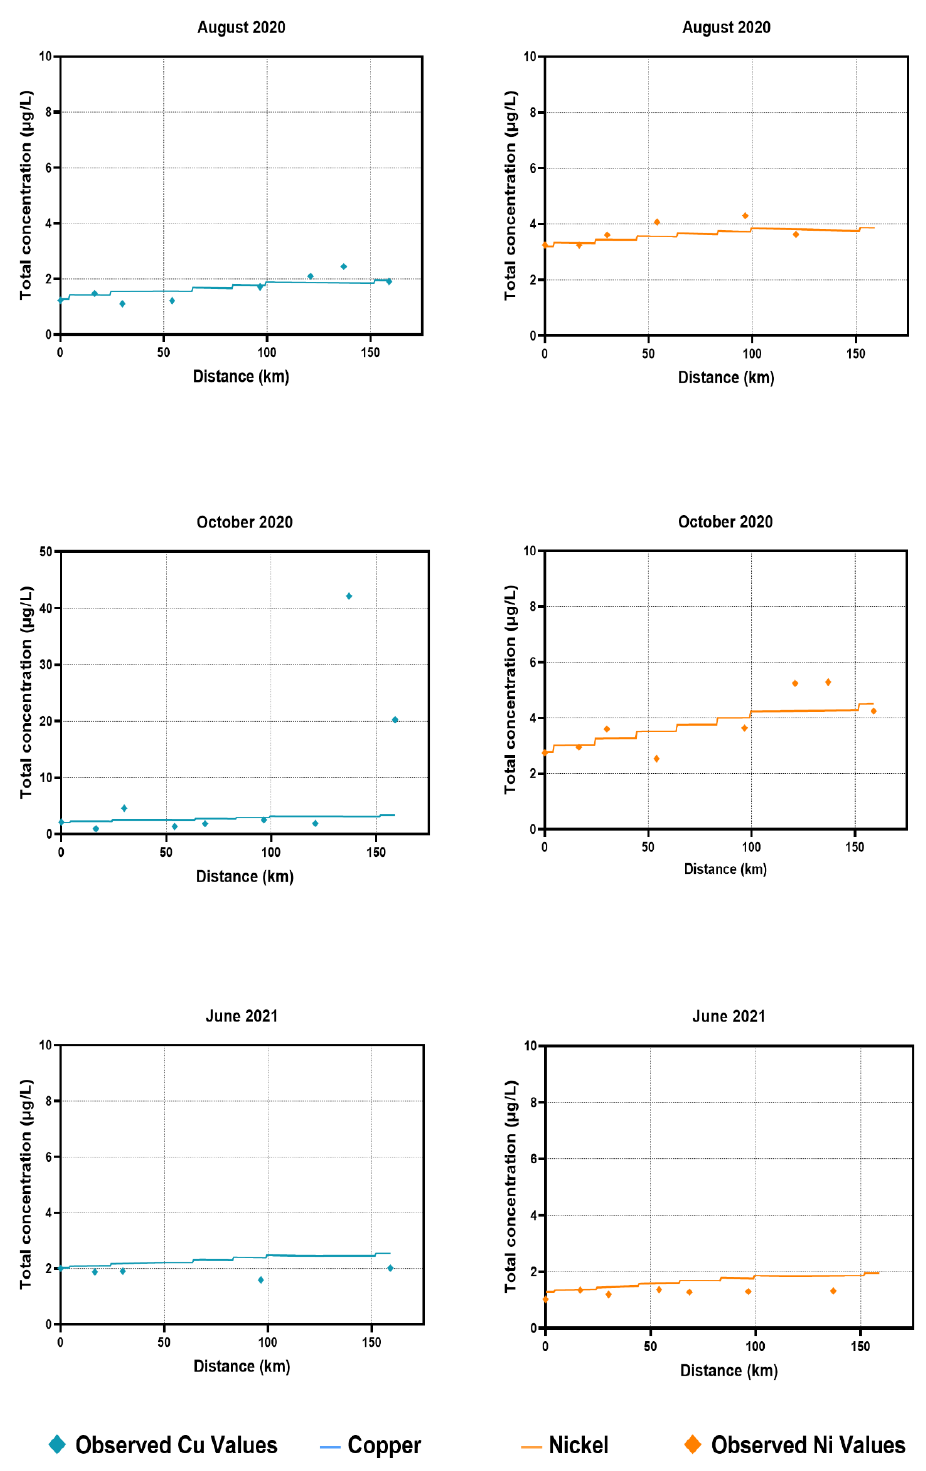
Figure 5. Longitudinal profiles of water concentrations with observed values for both trace metals in the 2020 and 2021 field seasons.